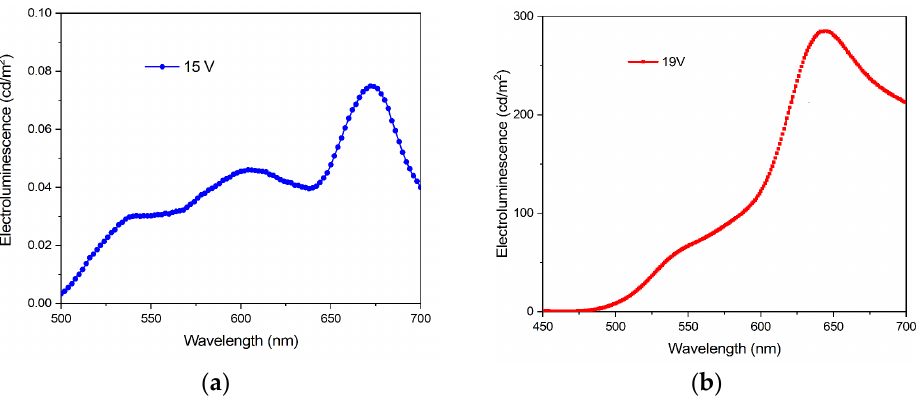
Figure 6. Electroluminescence of an OLED with ( a ) an electrospun cathode; ( b ) a thin film cathode.